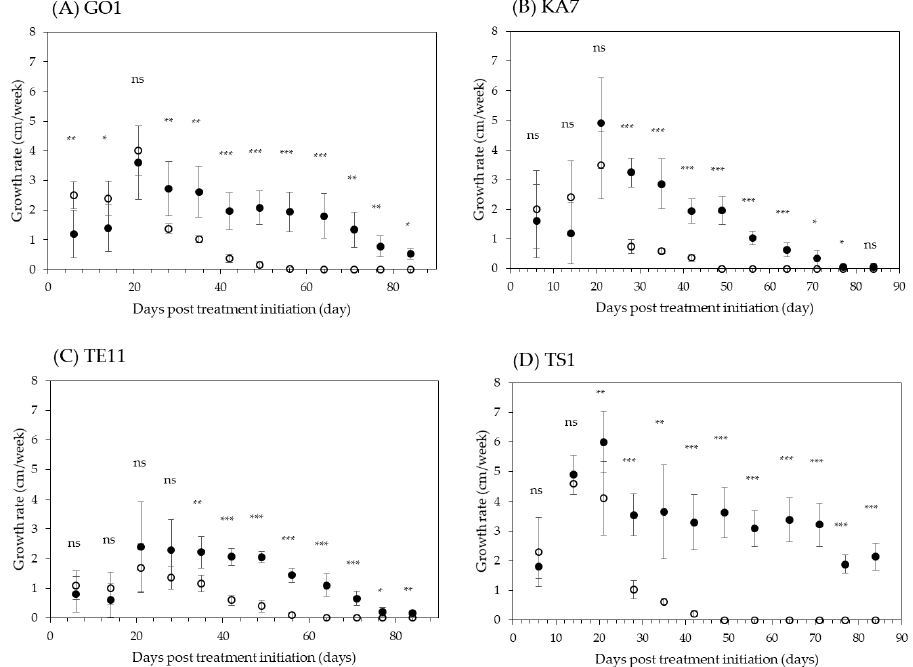
Figure 4. Temporal changes in the growth rates in the four clones. ( A – D ) show the results of GO1, KA7, TE11, and TS1, respectively. Open and closed circles denote the drought and control treatments. Statistical significance of the growth rates between treatments at each dpt for each clone was evaluated by Student’s t -test (ns: not significant, *: p < 0.1, **: p < 0.05, and ***: p < 0.01).